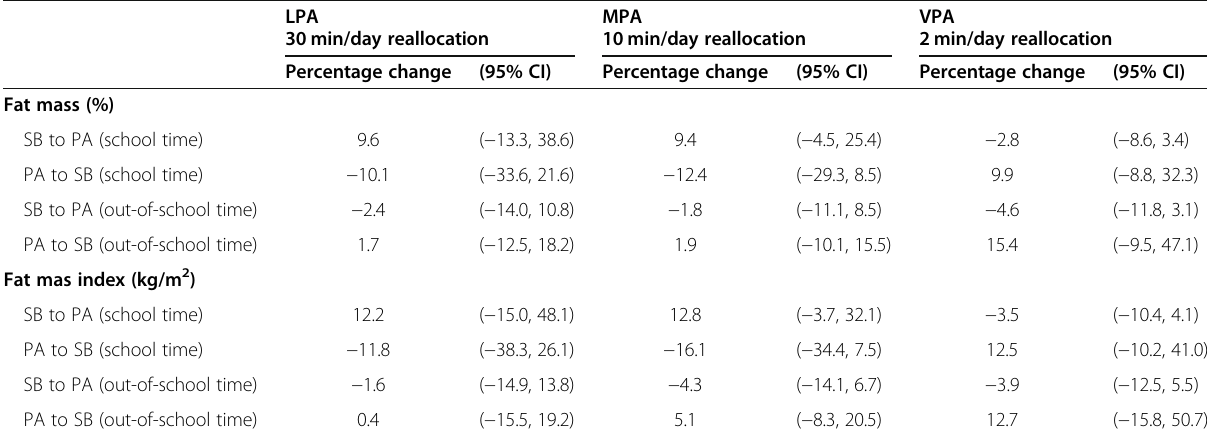
Table 3 Estimated relative difference in adiposity associated with replacing context-specific sedentary behaviors with physical activity among boys ( n = 128) LPA 30 min/day reallocation